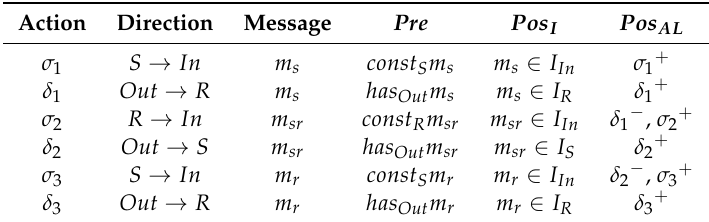
Table 2. Action model in the protocol.